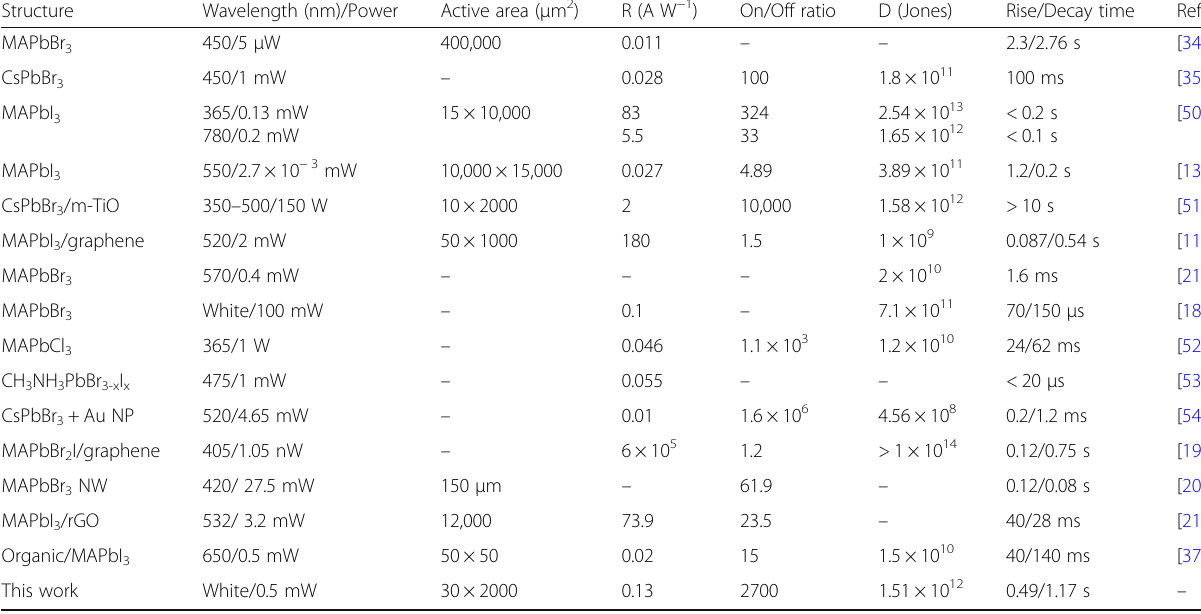
Table 1 Performance of photodetectors based on different perovskite materials